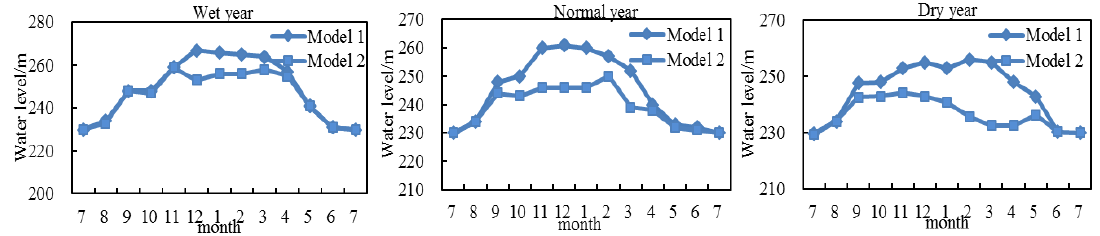
Figure 6. Water level change of the Xiaolangdi reservoir in each typical year.